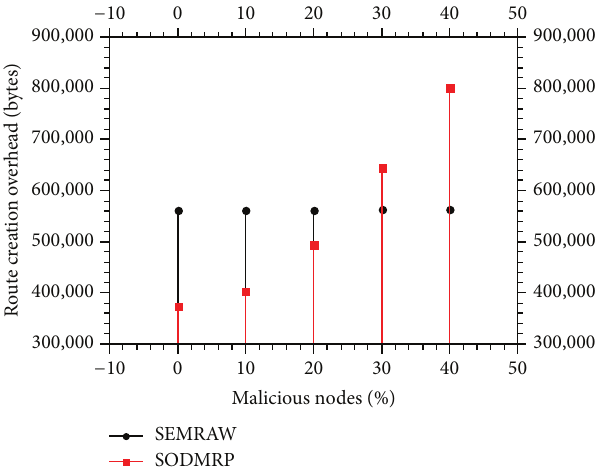
Figure 3: Route creation overhead for varying number of malicious nodes.